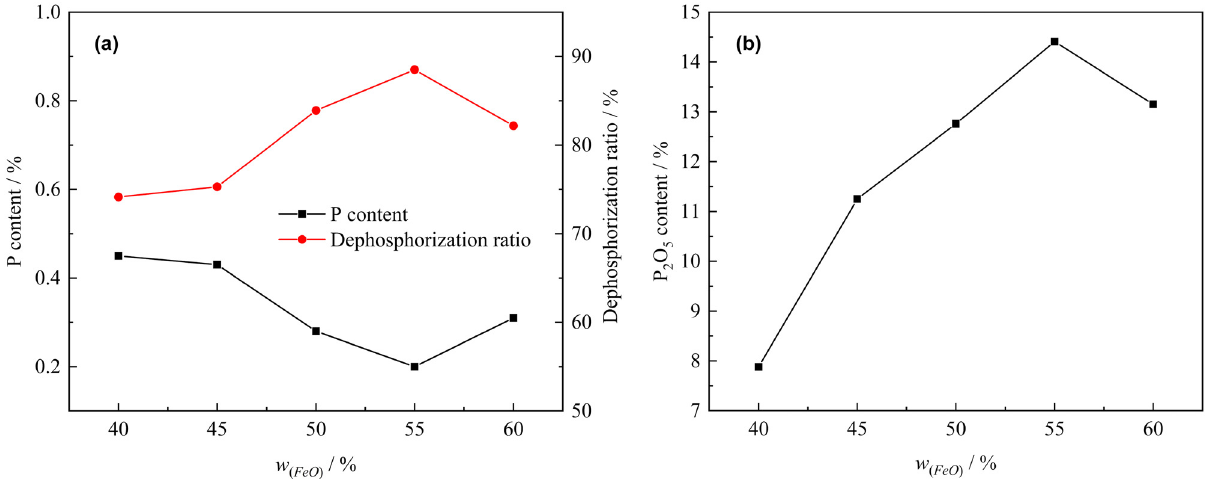
Figure 3: E ff ect of the FeO content on the P content of the fi nal metal and the P 2 O 5 content of the high - P - containing slag: ( a ) P content and dephosphorization ratio and ( b ) P 2 O 5 content.